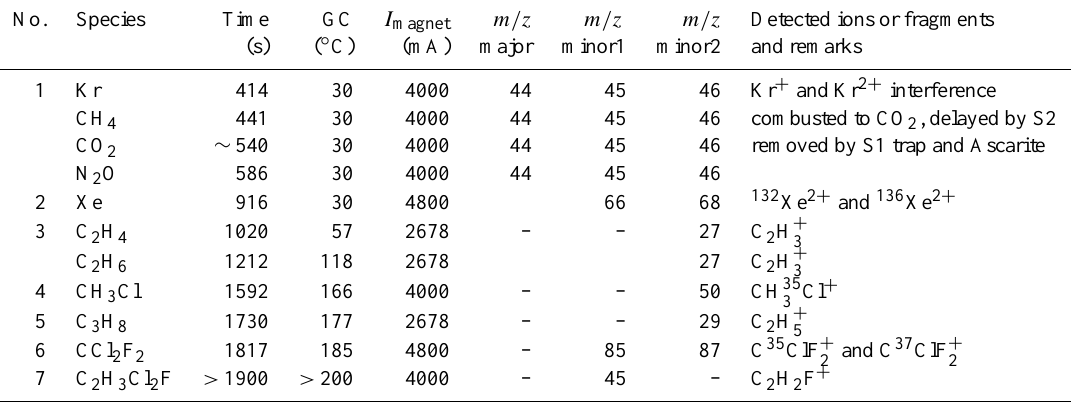
Table 1. Overview of measured species with their corresponding cup configurations for the seven individual acquisition runs. Time (s) is the elapsed time after the cryofocus trap is lifted, i.e. when a sample is injected onto the GC column. GC ( ◦ C) denotes the temperature in the GC when the respective peak is detected in the IRMS. The duration between leaving the GC column and IRMS detection is about 25s for species eluting at 30 ◦ C and increases to 50 s at 220 ◦ C at the end of the chromatogram due to dropping of the flow rate at higher temperatures. I magnet denotes the magnet current of the focus setting of the mass